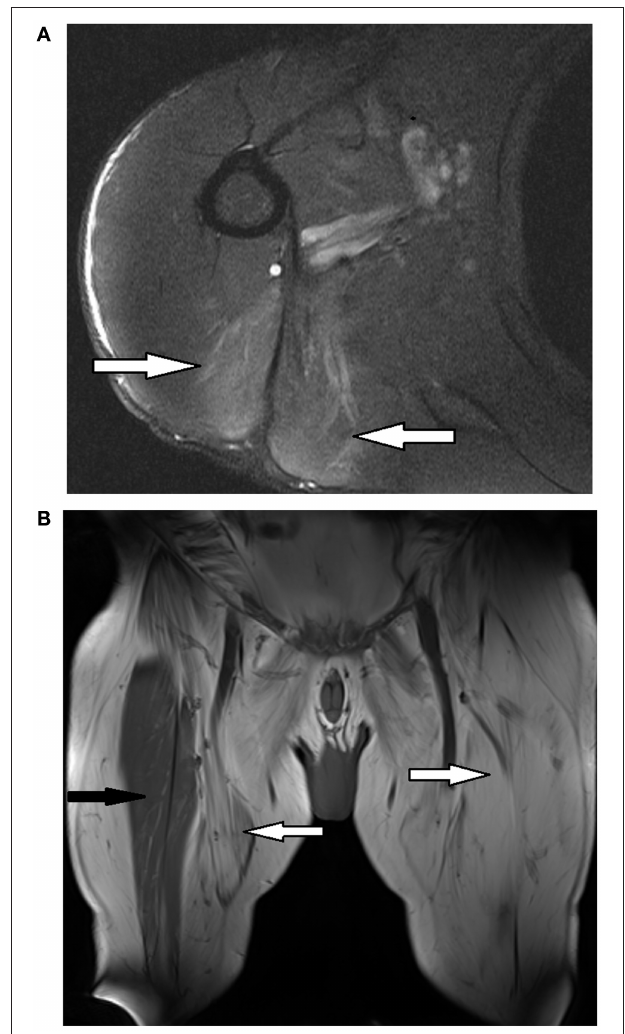
FIGURE 1 | Magnetic resonance imaging (MRI) of selected muscles from patients 1 and 2. (A) Left shoulder of patient 1 - axial T2* weighted sequence showing increased T2 signal of teres major and long head triceps (white arrows). (B) Bilateral thighs of patient 2 - coronal T1 ∧ weighted sequence showing extensive fatty replacement of anterior and medial thigh muscles (white arrows) with relative preservation of the right rectus femoris (black arrow). *T2, transverse relaxation time; ∧ T1, longitudinal relaxation